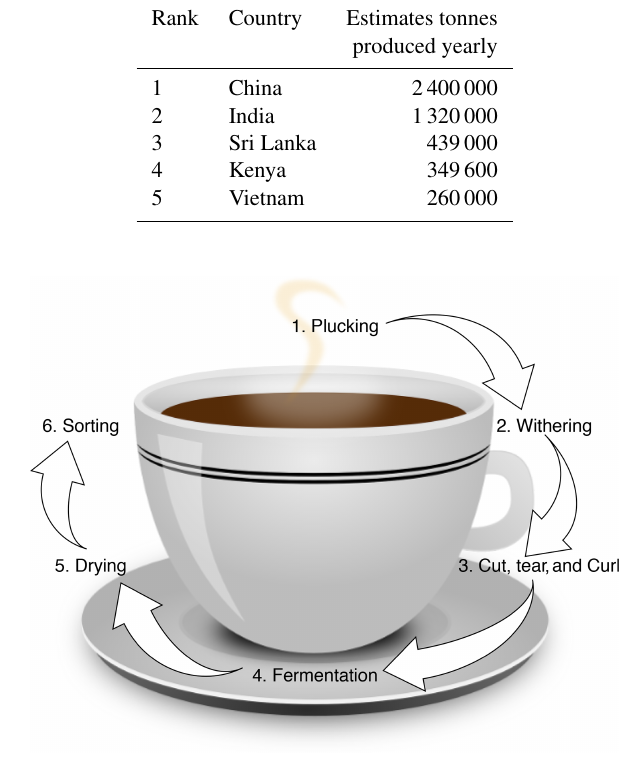
Figure 1. The basic processing steps of black